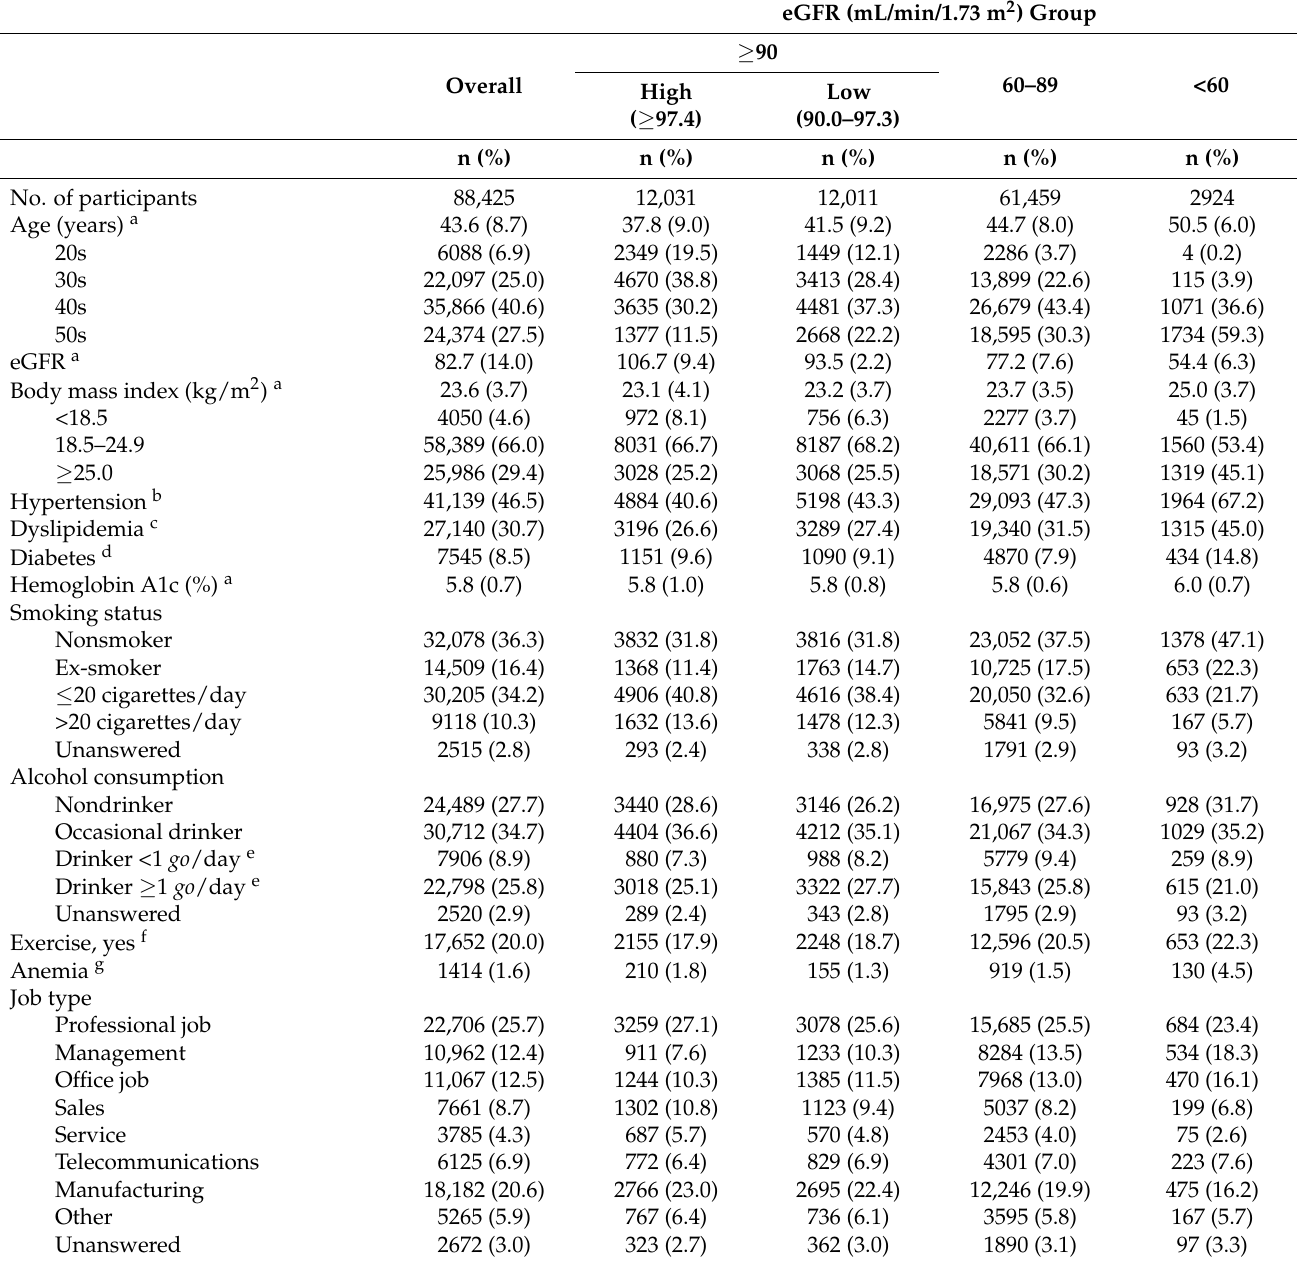
Table 1. Baseline characteristics according to estimated glomerular filtration rate groups in male